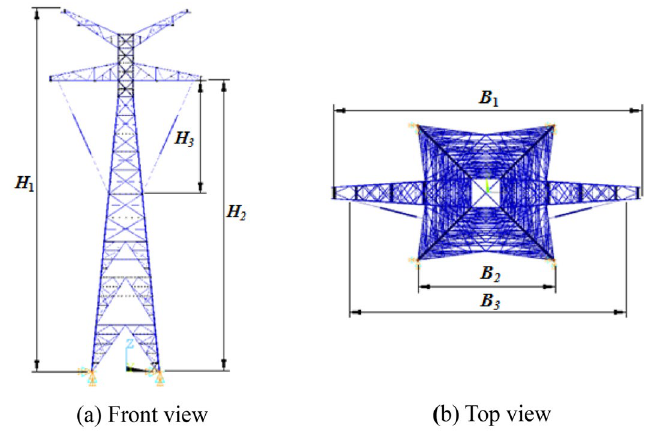
Figure 6. Finite element model of 500 kV ISLSTT with vibration reduction